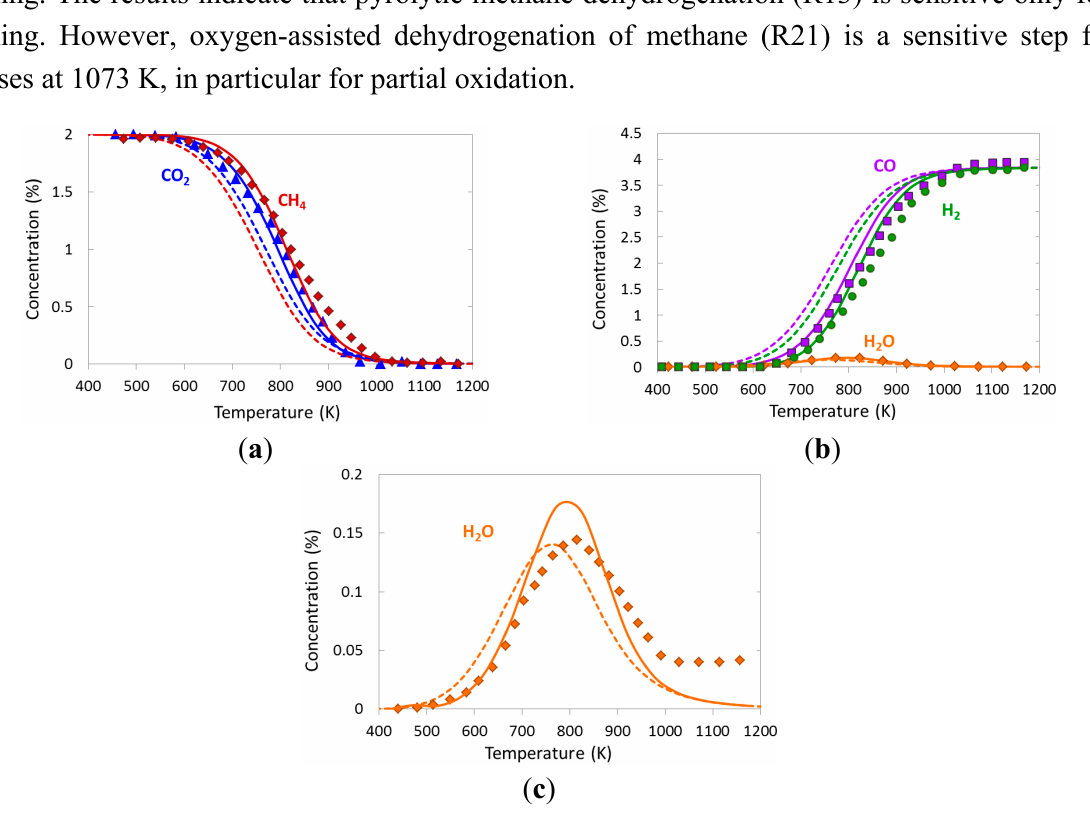
Figure 10. Comparison of experimentally determined (symbols) and numerically predicted (lines) concentrations as a function of temperature for catalytic reforming of methane with CO 2 : ( a ) reactants; ( b ) products; ( c ) zoom-in H 2 O formation; for CH 4 /CO 2 = 1 in N 2 ; 1 bar; T inlet = 373 K; total flow rate of 4 slpm, dashed lines = equilibrium composition at given